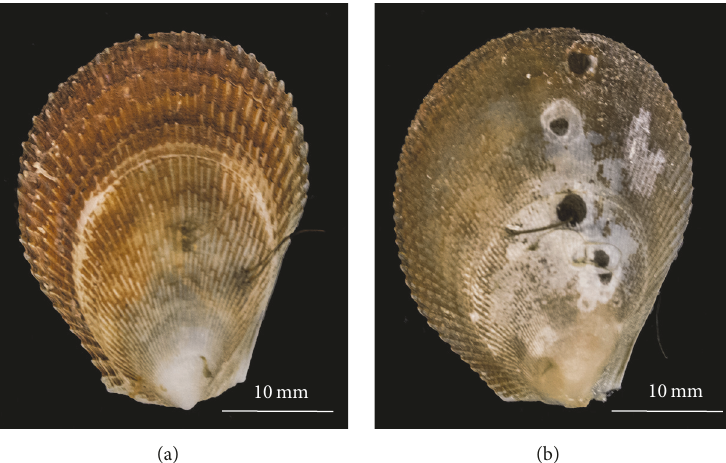
Figure 5: (a) Representative valve of C. scaber ; individual UCM 48137 (University of Colorado Museum of Natural History). Shell height 35.4 mm; shell ribs 𝑛 = 50 . (b) Representative valve of C. mitis ; individual UCM 48138. Shell height 34.7 mm; shell ribs 𝑛 = 80 . Scale bar =